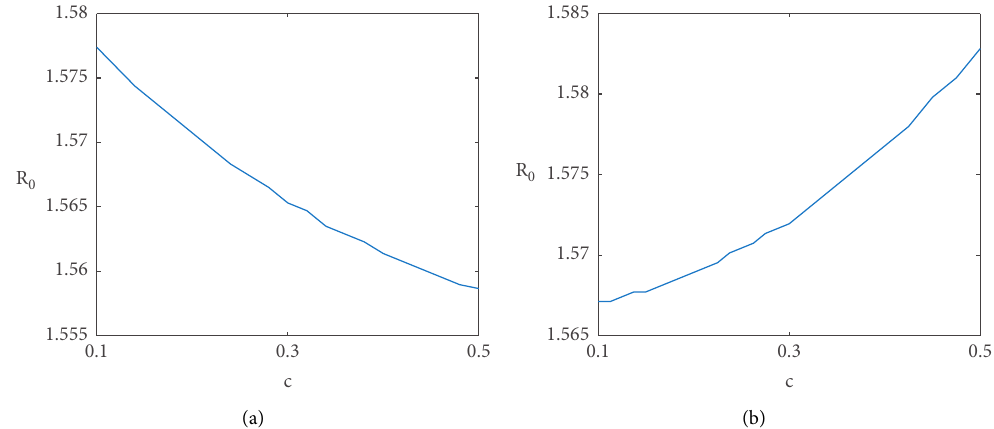
Figure 3: The influence of spatial heterogeneity on R (b) β ( x ) � 0 . 45 × ( 1 + 0 . 5cos ( 2 π x ))